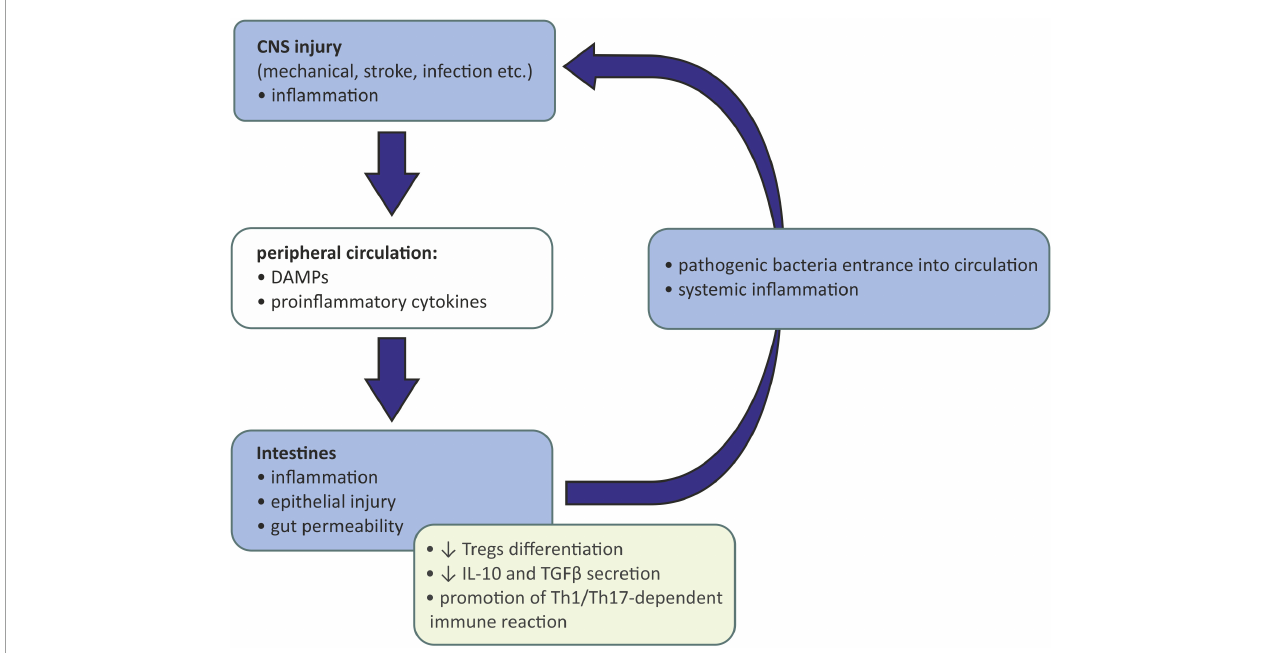
FIGURE2 Influence of injured and inflamed central neurons system on gut microbiota. CNS, central nervous system; DAMPs, damage-associated molecular patterns; IL-10, interleukin 10; TGF β , transforming growth factor β ; Th-1, T helper 1 cells; Th-17, T helper 17 cells; Tregs, regulatory T cells.